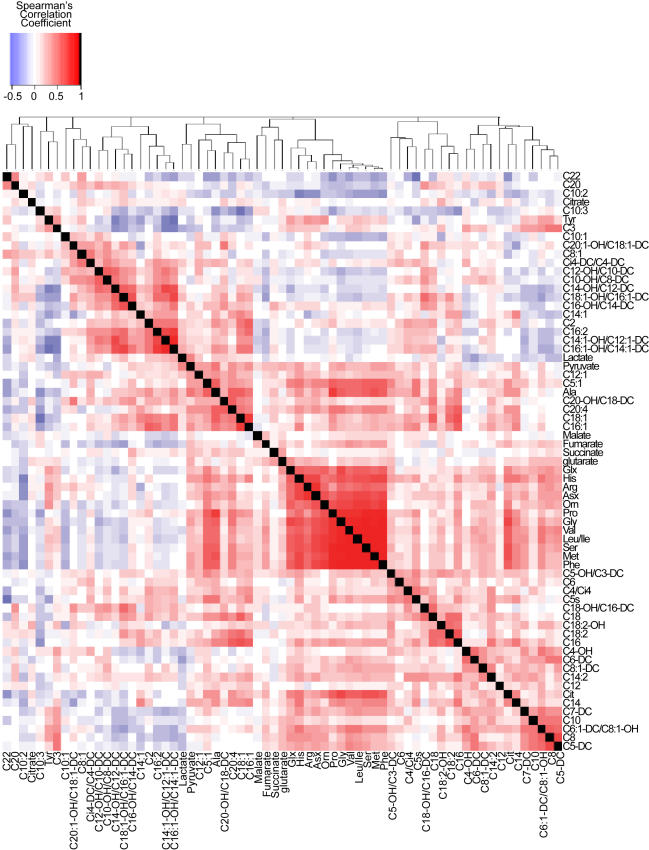
Heat map of correlations between liver metabolites.Each square represents the Spearman's correlation coefficient between the metabolite of the column with that of the row (|r|>0.254, p<0.05; |r|>0.330, p<0.01). Metabolite order is determined as in hierarchical clustering using the distance function 1-correlation. Self-self correlations are identified in black. Acyl-carnitines are annotated according to clinical acyl-carnitine profile shorthand and amino acids by three letter code; other metabolite abbreviations are found in Table S1. Individual correlation coefficients can be found in Table S2.